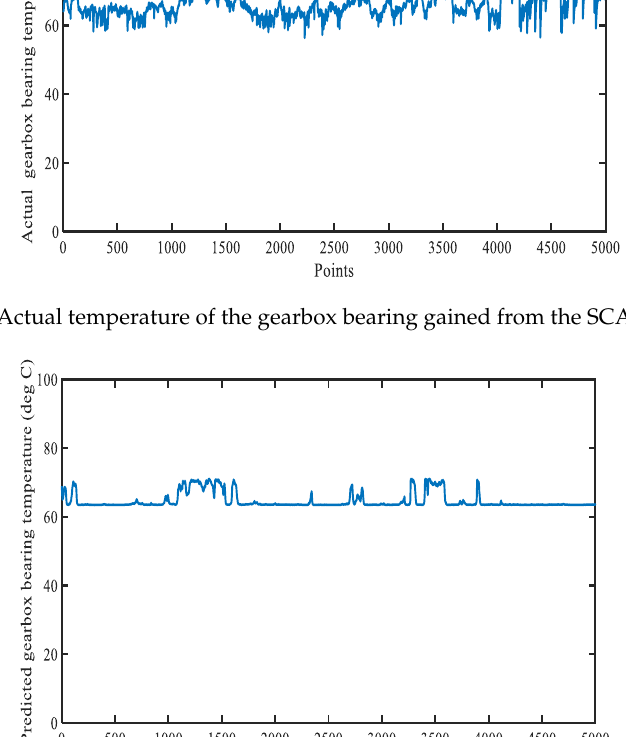
Energies 2019 , 19 , x FOR PEER REVIEW 13 of 15 Figure 18. Predicted temperature of the gearbox bearing gained from the LSTM model. Figure 18. Predicted temperature of the gearbox bearing gained from the LSTM model. Figure 18. Predicted temperature of the gearbox bearing gained from the LSTM model.